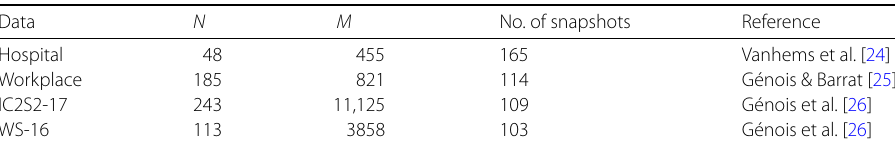
Table 1 Summary of properties for the datasets